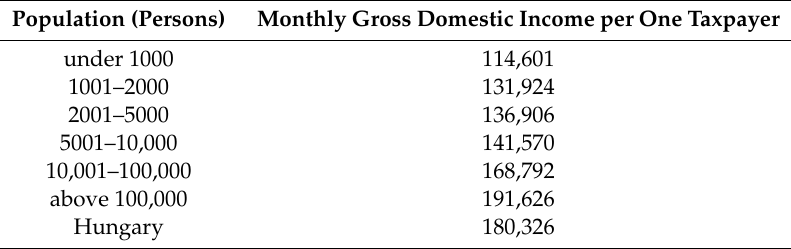
Table 1. The degree of monthly gross domestic income per taxpayer by population categories.